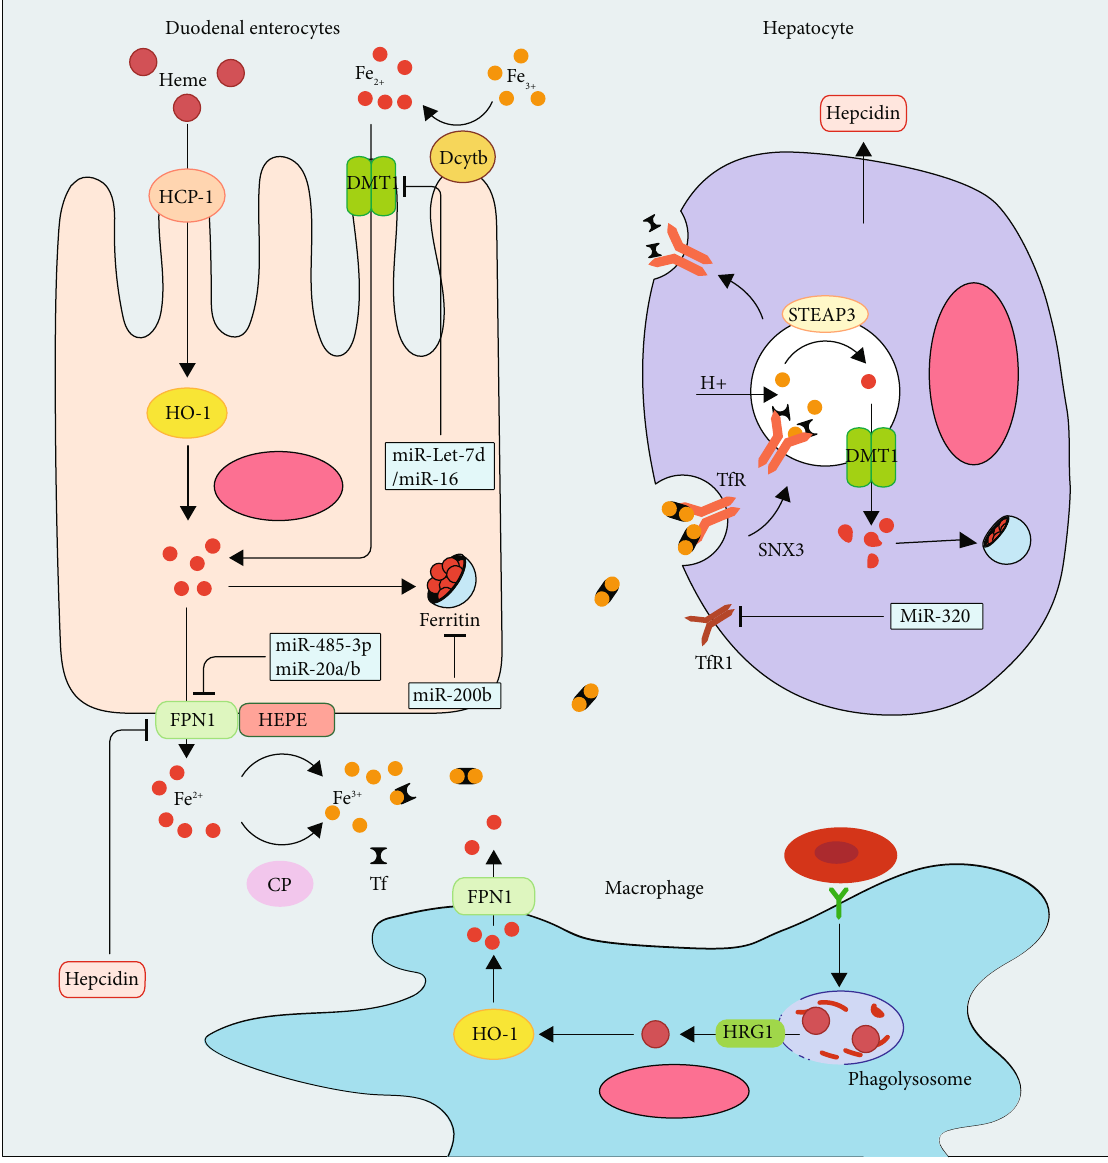
Figure 1: Systemic iron